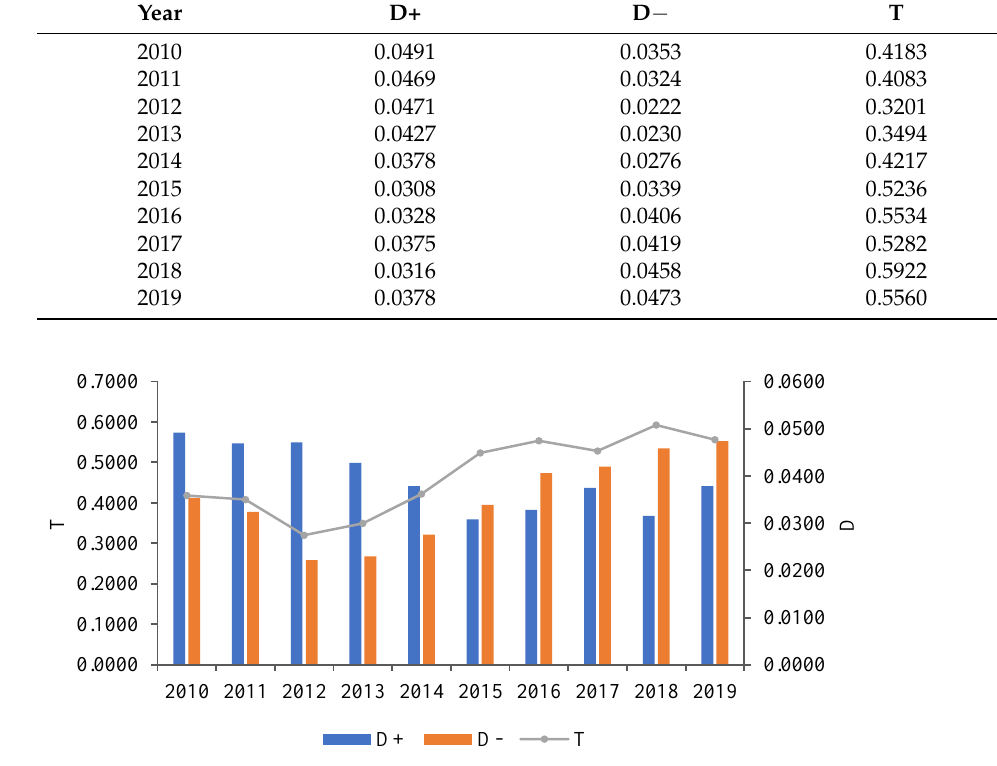
Figure 2. Change trend of comprehensive evaluation for water resource carrying capacity in Zhengzhou from 2010 to 2019.